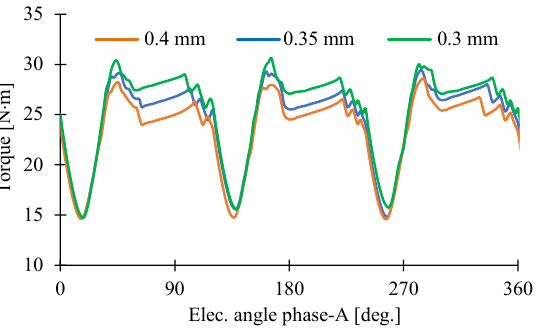
Figure 8. Dynamic electromagnetic torque from the MEC model at 5450 r/min at different airgaps.